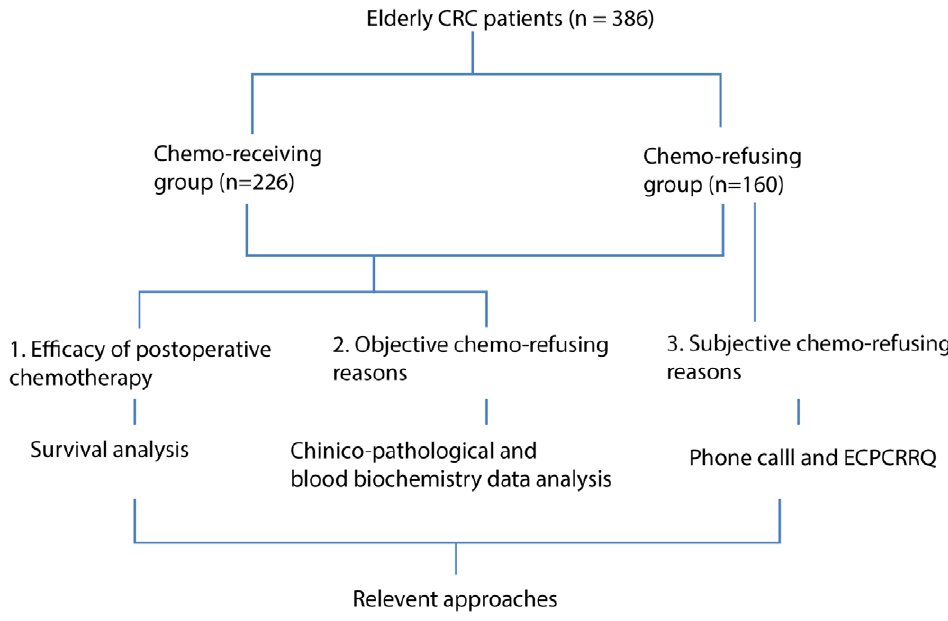
Figure 1. The chart of study design.